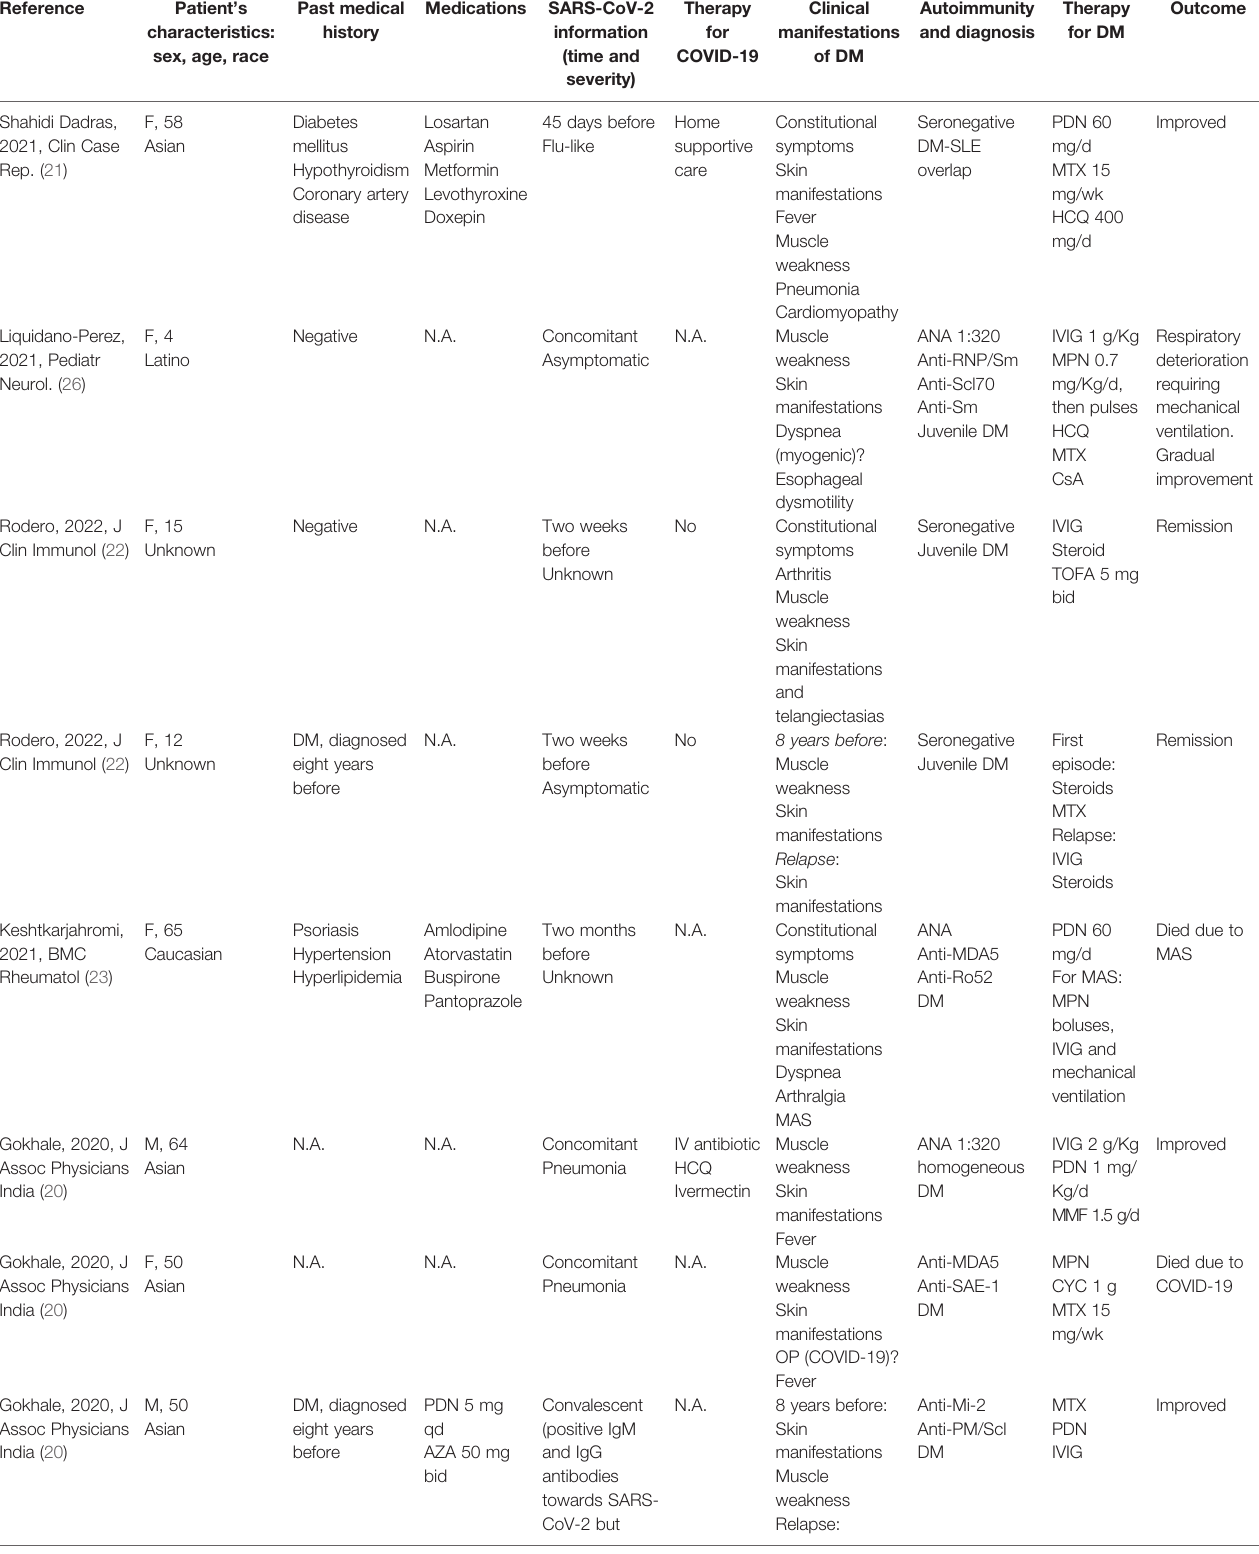
TABLE 1 | Relevant clinical features of previously reported cases of DM following SARS-CoV-2 infection.